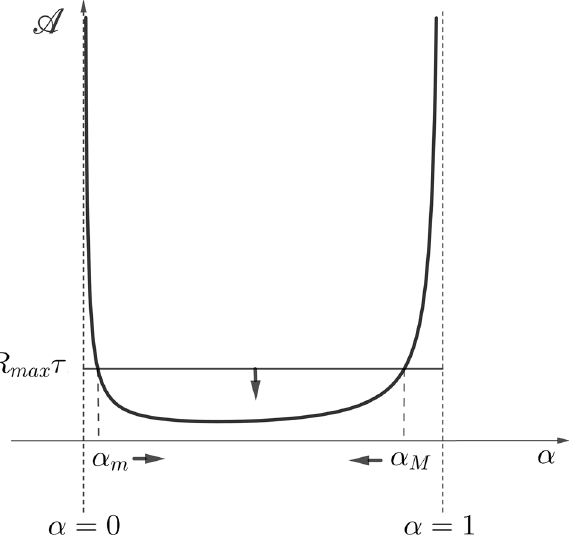
Figure 5. The individual consumption in the long term versus allocation strategy towards reproduction. Note that the size of the persistence range reduces with decreasing length of the cycle τ or of the maximum rate of consumption R max , which is indicated by the respective arrows. In addition, A = A (α) is a convex function, which implies that there is a unique allocation strategy, into the persistence range, that minimizes individual consumption in the long